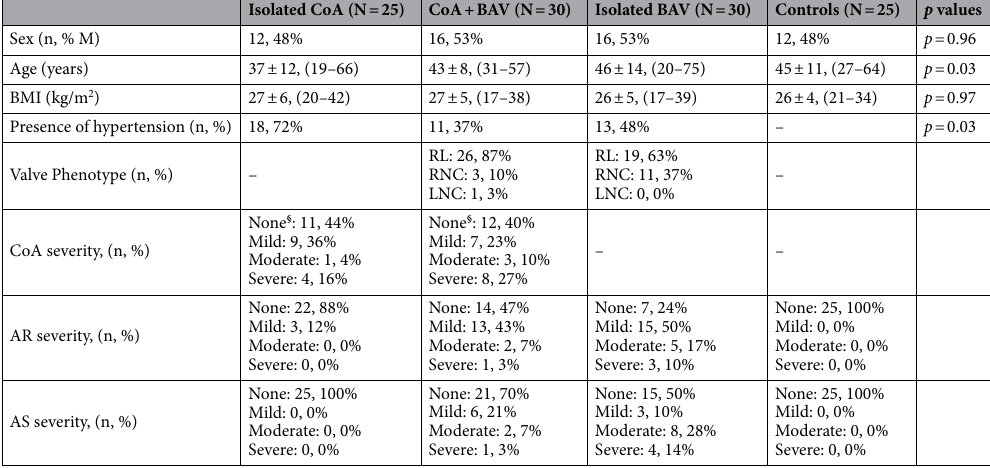
As it can be qualitatively appreciated, the template for isolated CoA patients is the shortest and more spherical compared to the others, followed by BAV-CoA and then isolated BAV, compared to the more elongated healthy controls. The first five principal component analysis shape modes (Fig. 4) represented 54% of the overall shape vari- ability in the population (Table 3), and hence the corresponding shape vectors were used for statistical analyses. Different modes captured different morphological features, after careful visual assessment and correlation with